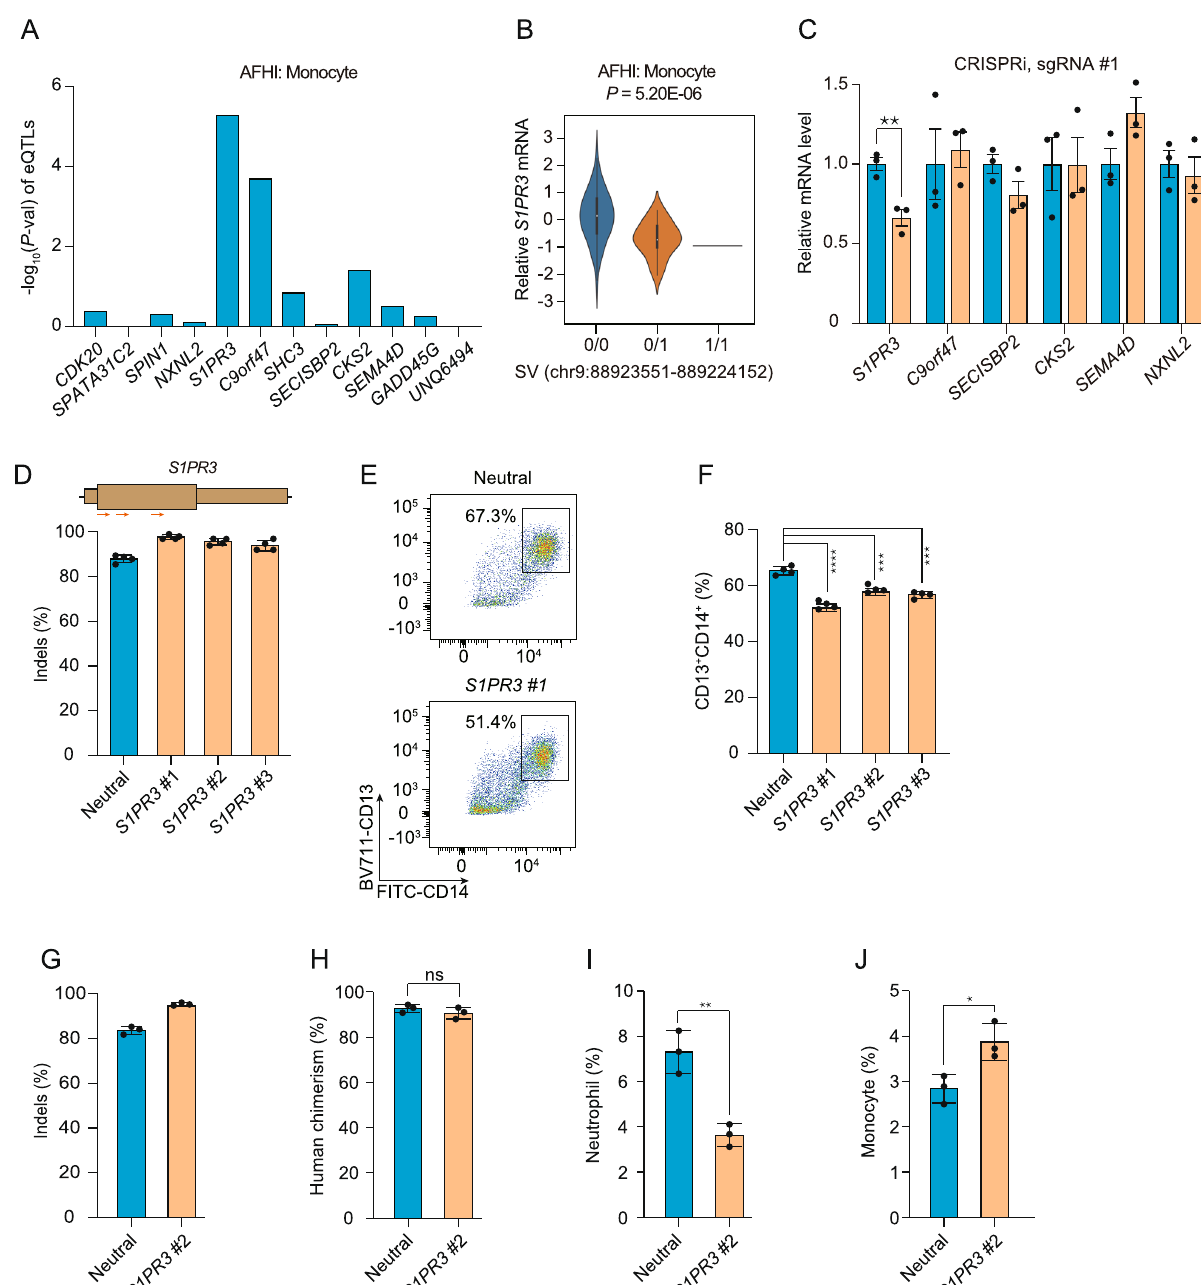
Fig. 2 | Genome and epigenome editing implicates S1PR3 in the 9q22.1 mono- cyte association. All p -values are derived from two-sided t-tests (unless otherwise indicated) and are not adjusted for multiple comparisons. A eQTL results between the 9q22.1 SV and genes within 1-Mb window in monocytes using data from from MESA, including n =77 AA and n =92 Hispanic/Latino participants. AFHI: African American and Hispanic/Latino. B Violin plot (with minima, maxima, median, and inter-quartile range) demonstrating the correlation between the 9q22.1 SV geno- typeandexpressionof S1PR3 ,in n =169fromMESA. C Expressionofgeneswithina 2Mb window in THP-1 cells expressing dCas9-KRAB after transduction with an sgRNAs targeting the SV (orange) as compared to a neutral locus control sgRNA (blue). Relative mRNA level of each gene was represented by mean±standard deviation (SD). N =3 biological replicates, where each replicate is a unique